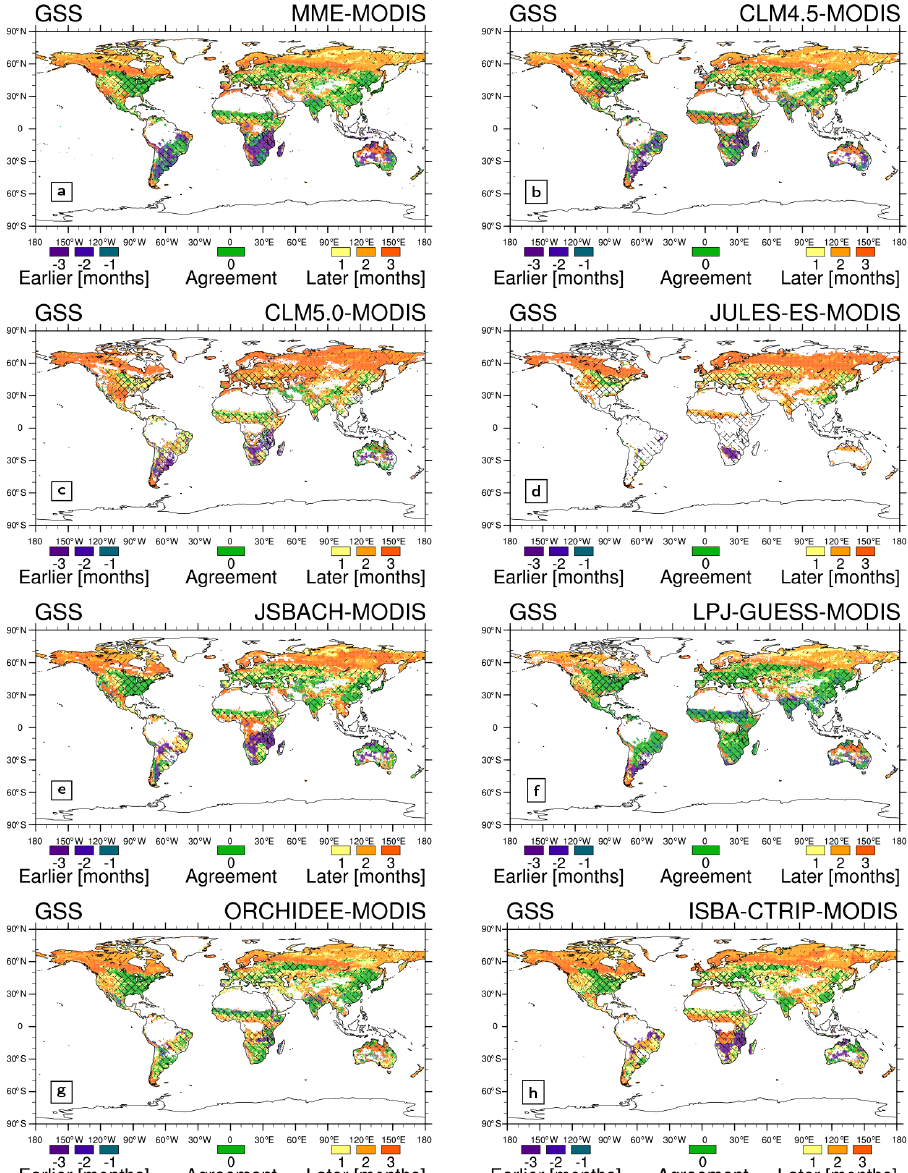
Figure 4. Global climatological (averaged over 2000–2011) differences in the growing season start timings (GSS) between (a) multi-model ensemble mean (MME), (b) CLM 4.5, (c) CLM 5.0, (d) JULES-ES, (e) JSBACH, (f) LPJ-GUESS, (g) ORCHIDEE, and (h) ISBA-CTRIP and MODIS (Fig. 2b). The green regions represent areas of agreement between MODIS and LSMs. Yellow-red colours correspond to areas where models timings are later compared to MODIS, while blue-violet colours correspond to areas where models timings are previously compared to MODIS. Regions where GSS timings are not computed, such as non-vegetated and evergreen areas, are in white. Above this selection, areas of agreement between satellite products are shaded with a different hatching pattern: MODIS and LAI3g (Fig. 2d) slash hatching (/); MODIS and CGLS (Fig. 2g) backslash hatching ( \ ); MODIS, CGLS, and LAI3g crossed hatching ( × ). Note that the GSS in the TGS regions corresponds to the GSS of the first growing season